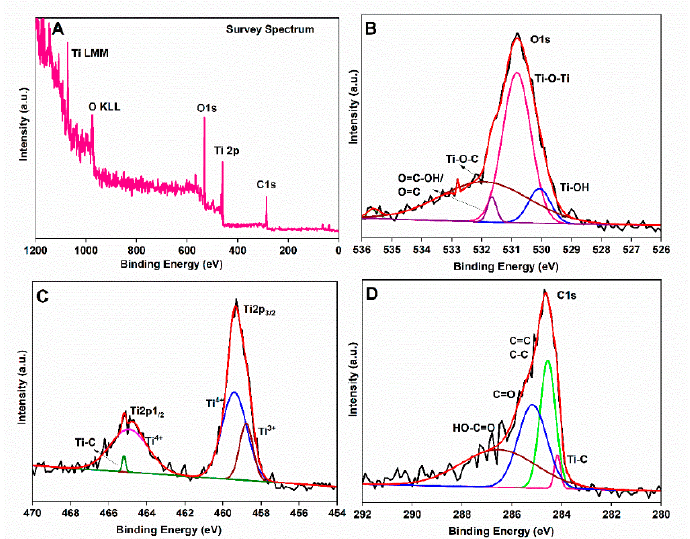
Figure 2. XPS analysis of the CTA-TNT@CNT sample: ( A ) Survey spectrum; ( B ) high-resolution O1s; ( C ) high-resolution Ti2p; and ( D ) high-resolution C1s core level analysis.